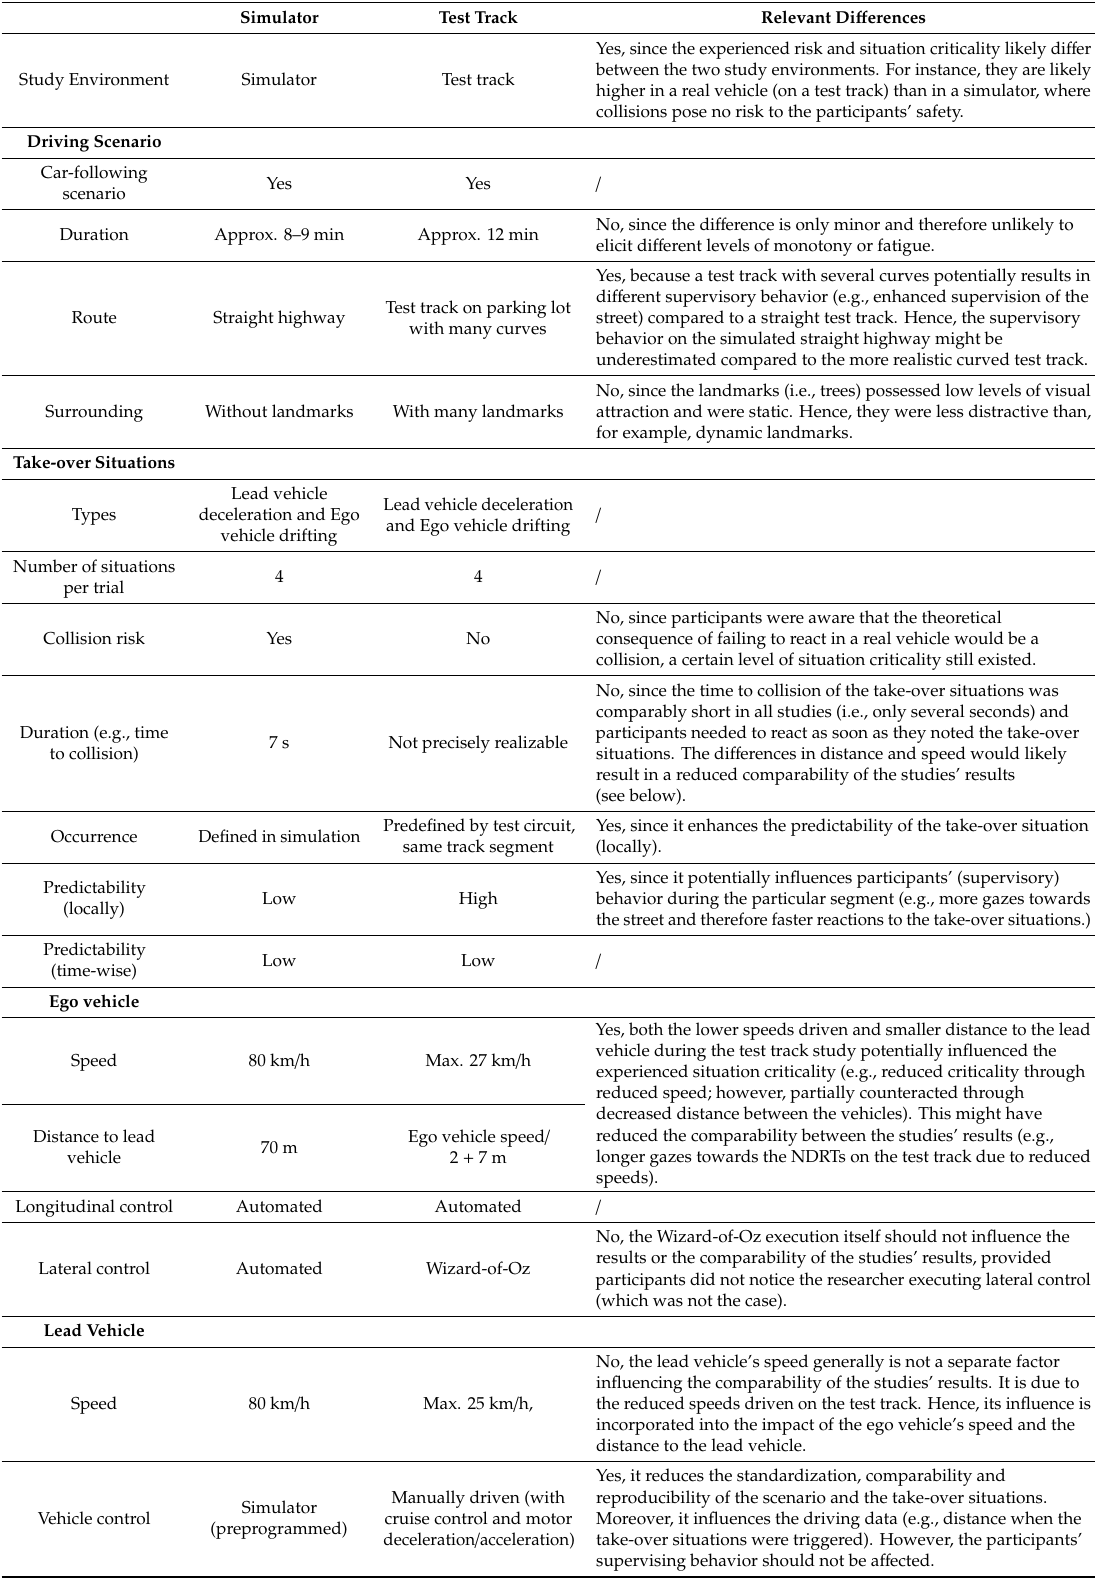
Table 1. Di ff erences and similarities between the simulator and test